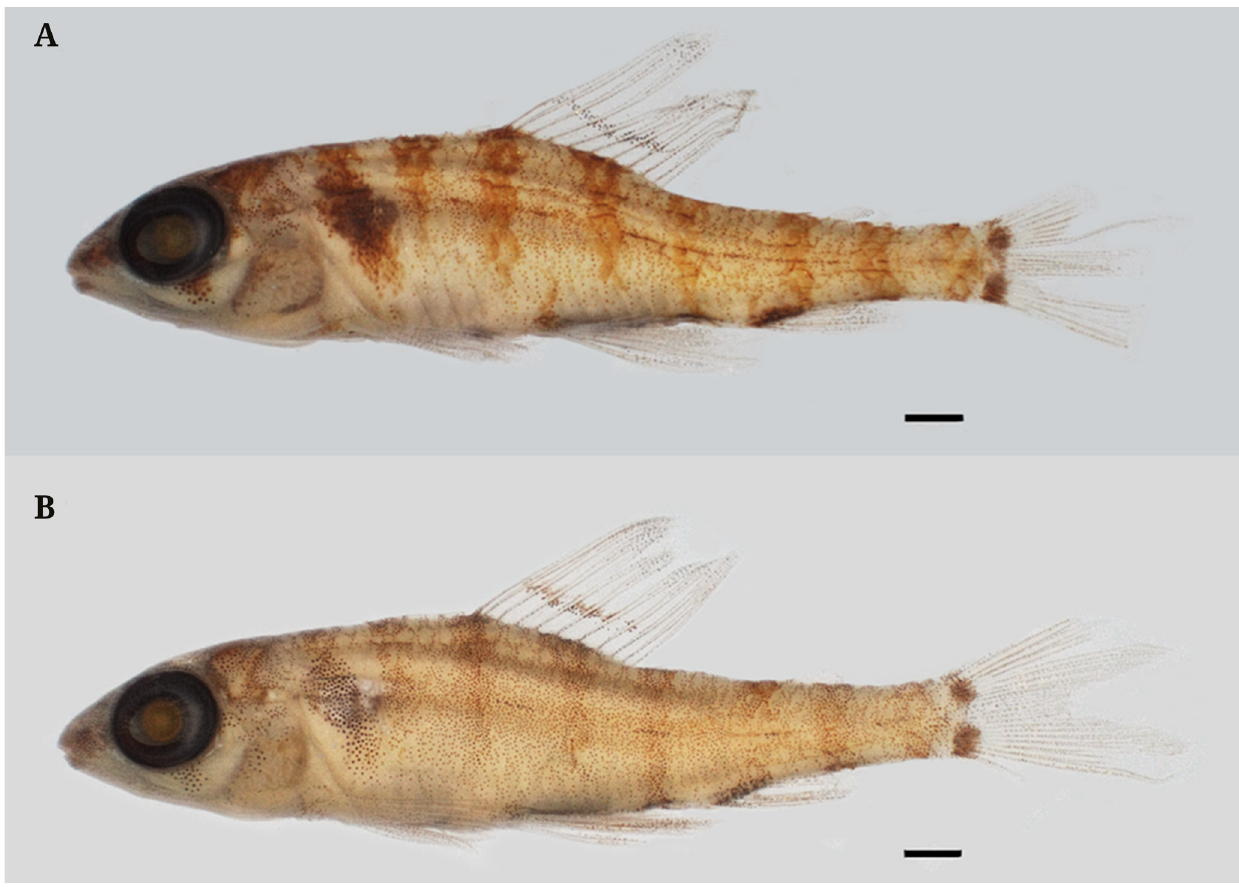
FIGURE 1 | Odontocharacidium varii , new species, A. Holotype, MHNLS 26156, 14.7 mm SL, Venezuela, Río Negro Municipality, Río Orinoco; Paratype, USNM 270149, 14.3 mm SL, Venezuela, Río Negro Municipality, Río Orinoco. Scale bar = 1